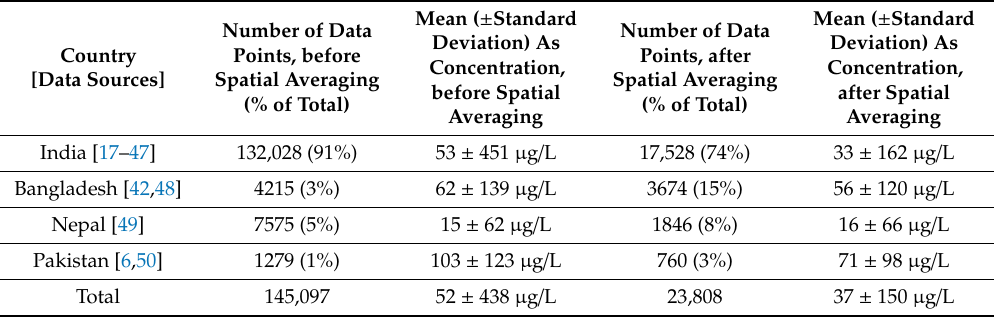
Table 1. Summary of groundwater arsenic concentration data used in the model. Existing arsenic measurements taken from over 30 sources, mainly from India but also from some neighboring South Asian countries. Summaries are given for before and after spatial averaging.